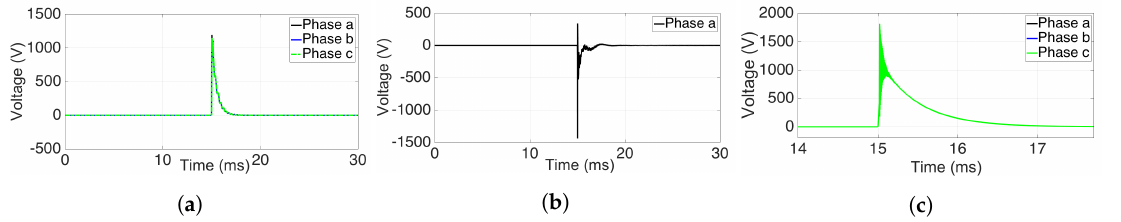
Figure 14. Impact of direct strike on out-of-service wind turbine overvoltages. ( a ) LV side of the main transformer; ( b ) HV side of the main transformer from node to ground; ( c ) control